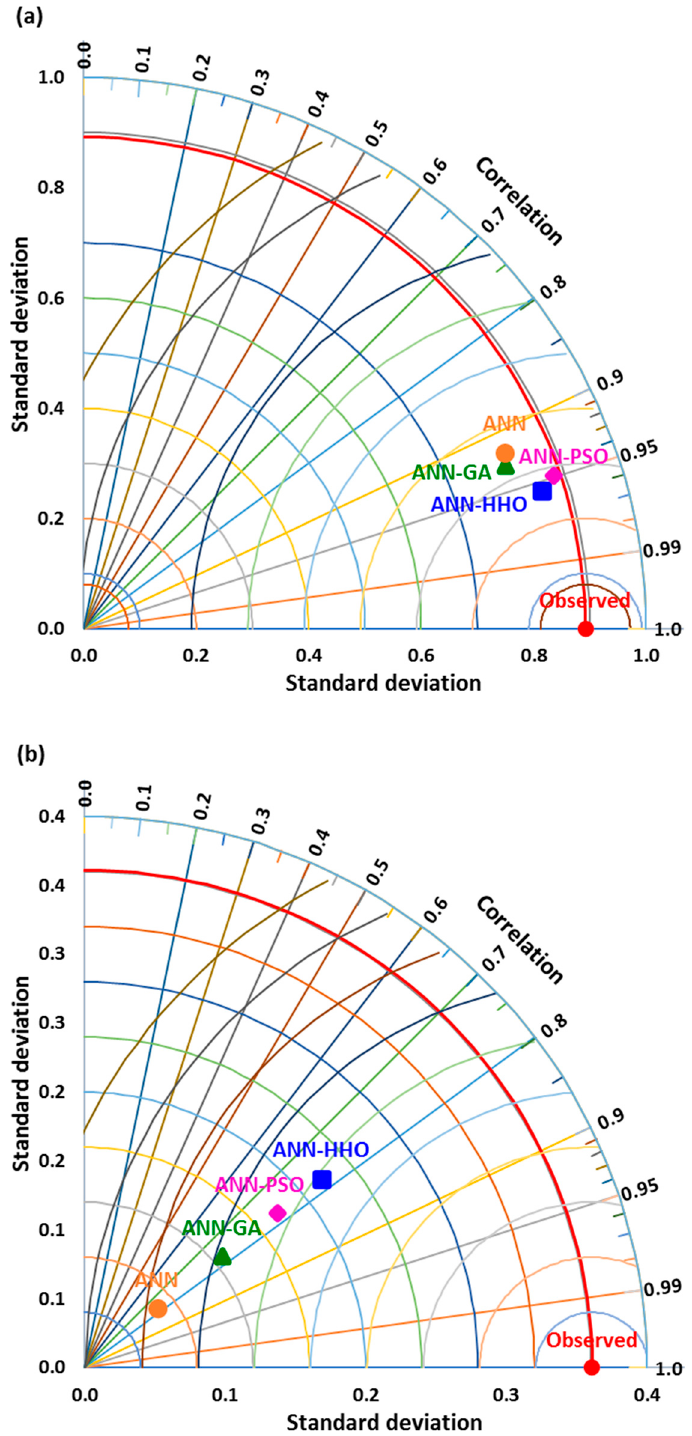
Figure 7. Taylor diagrams of ANN-HHO, ANN-PSO, ANN-GA, ANN models during ( a ) training, and ( b ) testing periods.